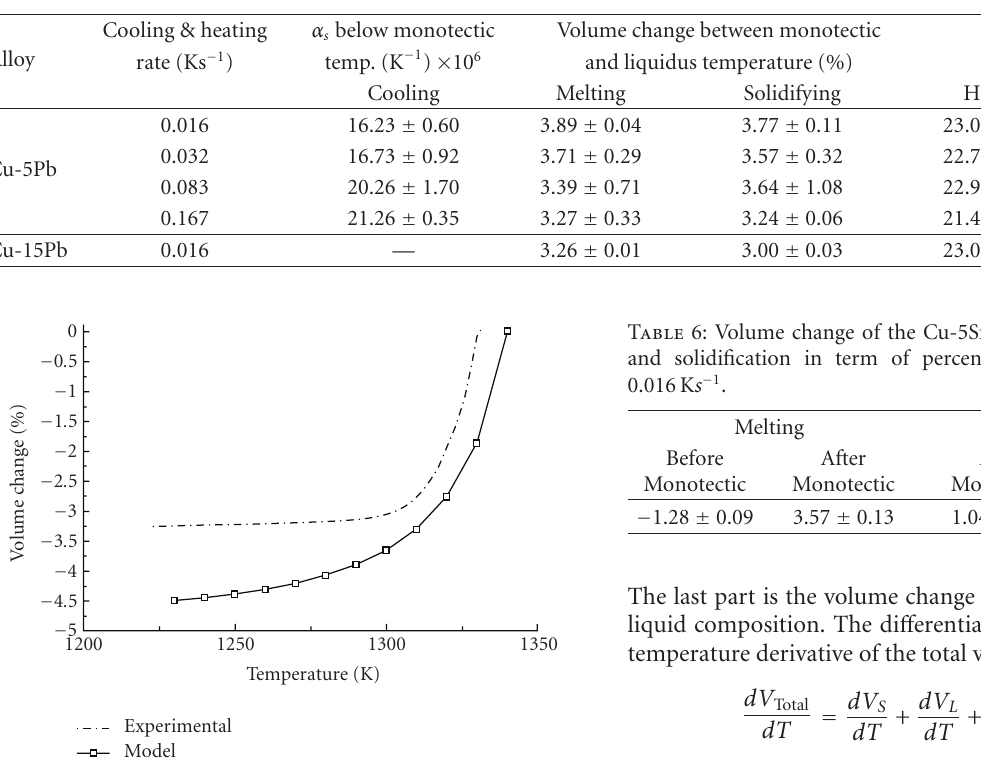
Table 5: Volume change and thermal expansion coe ffi cient of the Cu-Pb alloys.